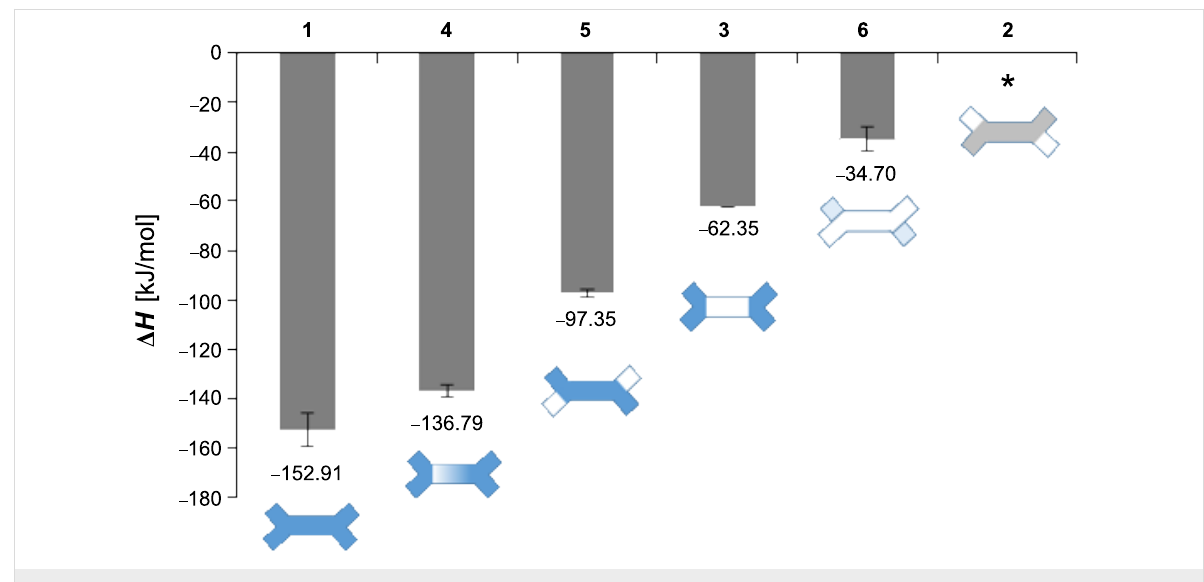
Figure 5: Polymerization heat, ∆ H p for the curing of 1–6 at 37 °C (* no polymerization heat detected).